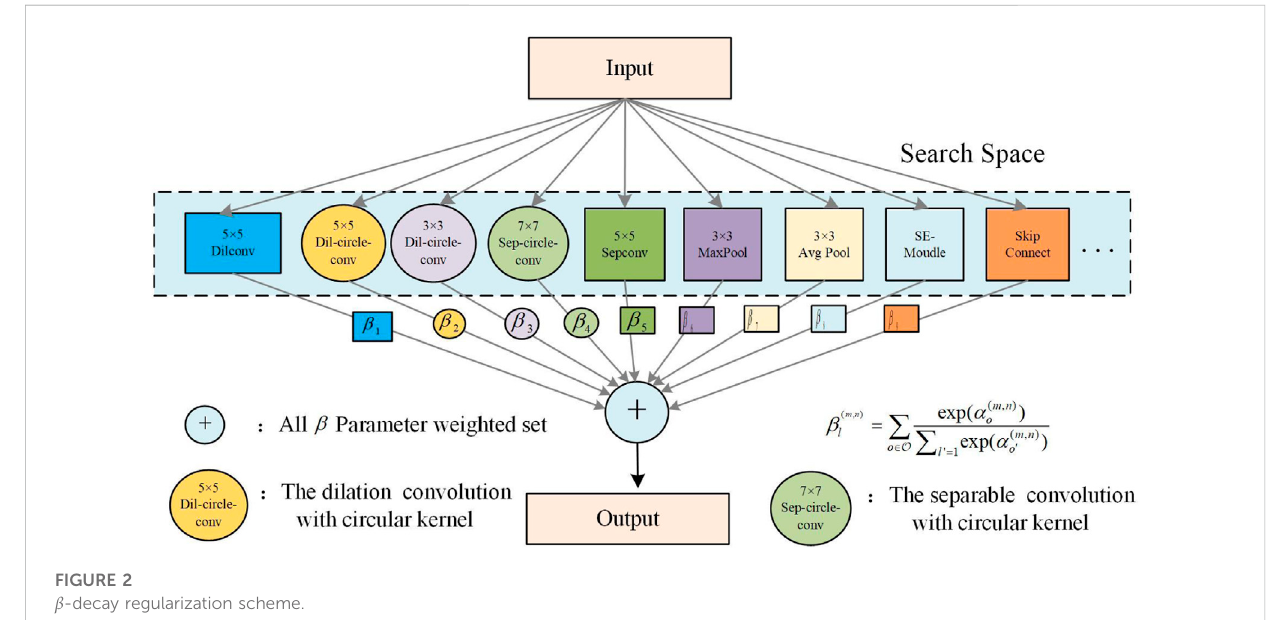
FIGURE 2 β -decay regularization